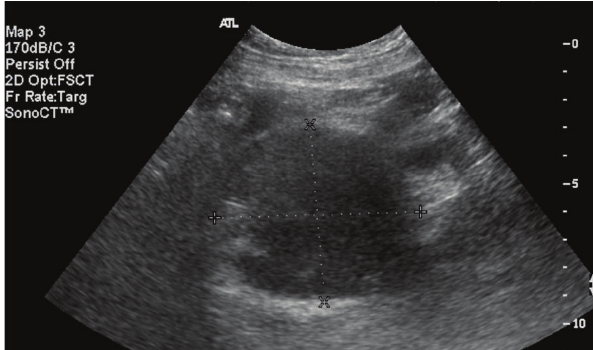
Figure 1: Pelvic ultrasound showing large mass adjacent to right bladder wall.